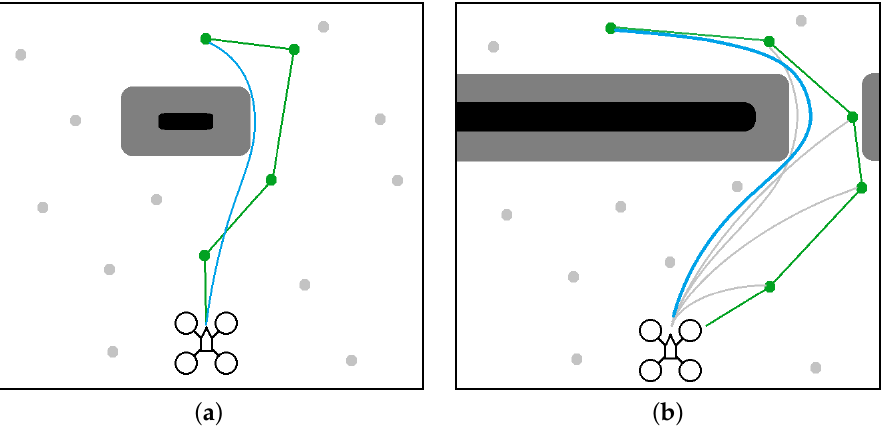
Figure 6. Graph-based vs NMPH path planning. ( a ) The terminal vertex of the green path (from graph-based planner) is sufficient to generate the optimum blue path by NMPH. ( b ) All the vertices of the green path are used successively to guide the solutions of NMPH to the final optimal trajectory (blue